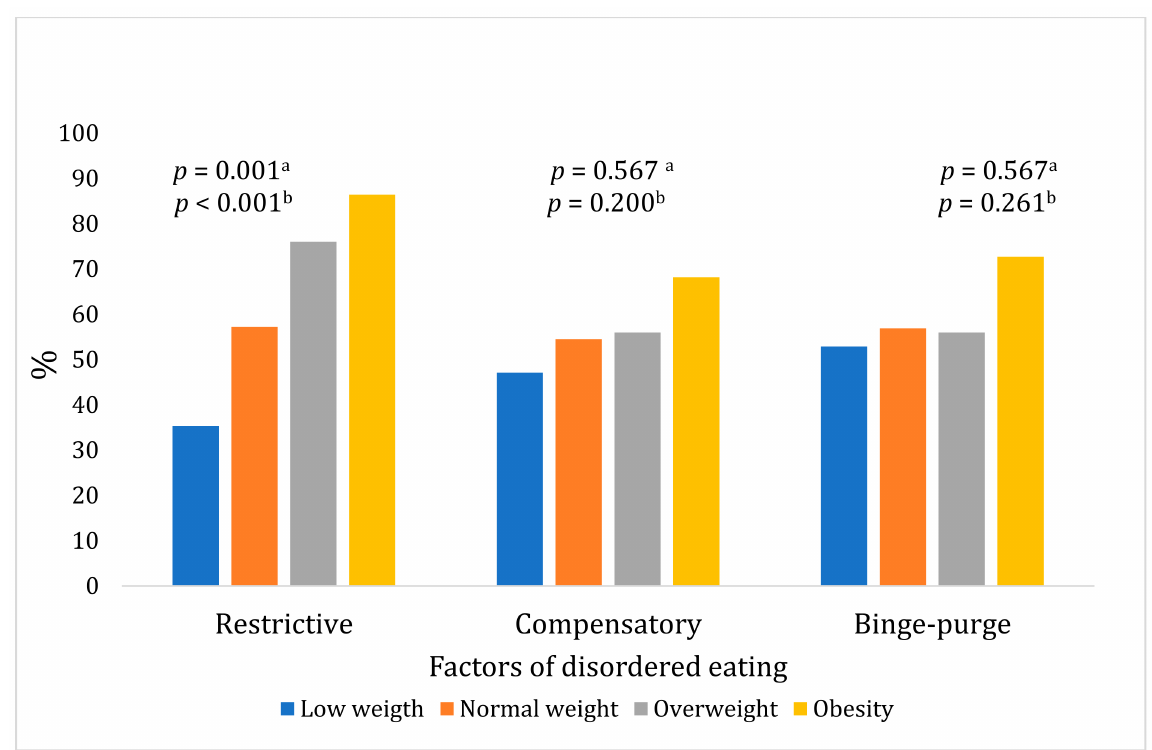
Figure 1. Disordered eating behaviors according to the pregestational BMI. a p -value based on Pearson’s Chi Square; b p -value based on linear association Chi-square